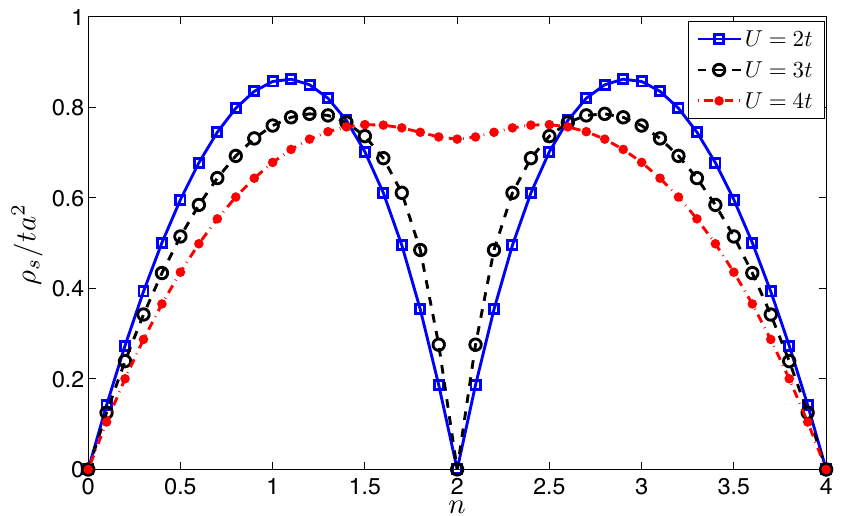
Figure 2. Superfluid densities (particle number per unit cell) are plotted as functions of the filling factor n (particle number per unit cell) with t ′ = 0.15 t , M = 0 and φ = π/ 2 . The three curves correspond to interaction U = 2 t , 3 t and 4t,